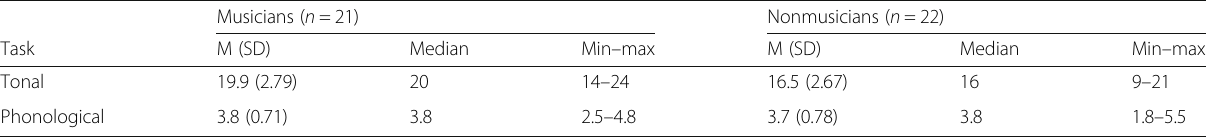
Table 1 Mean number of correct responses (M), with standard deviation (SD), median, and range (minimum-maximum) in tonal sequence recognition and pseudoword sequence recall tasks, for each group of participants